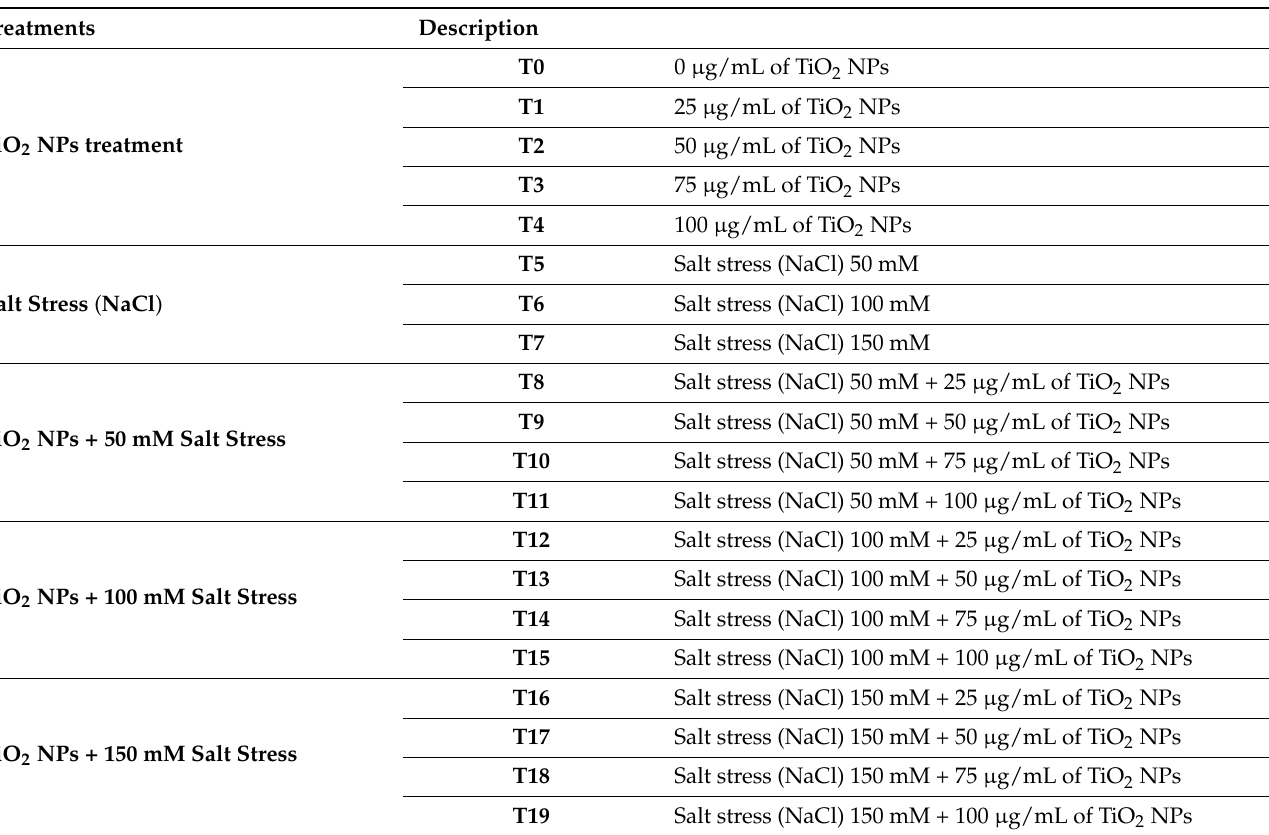
Table 1. Different treatments of TiO 2 NPs and NaCl on two wheat varieties (Pirsabak-05 and NARC- 09) under salinity